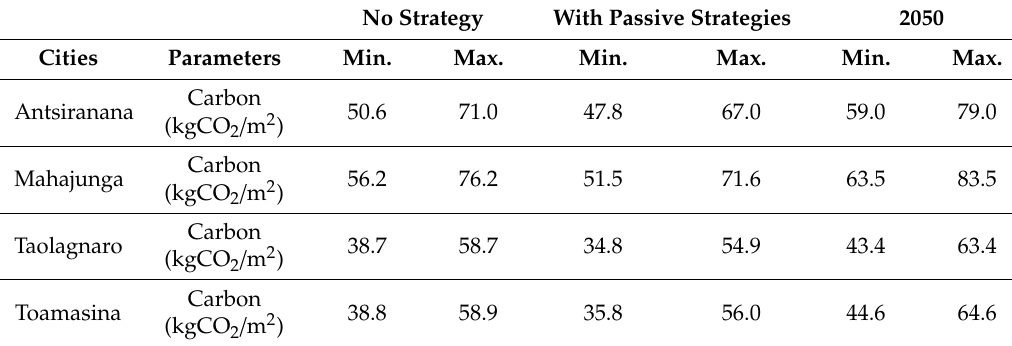
Table 6. Operational carbon in the four